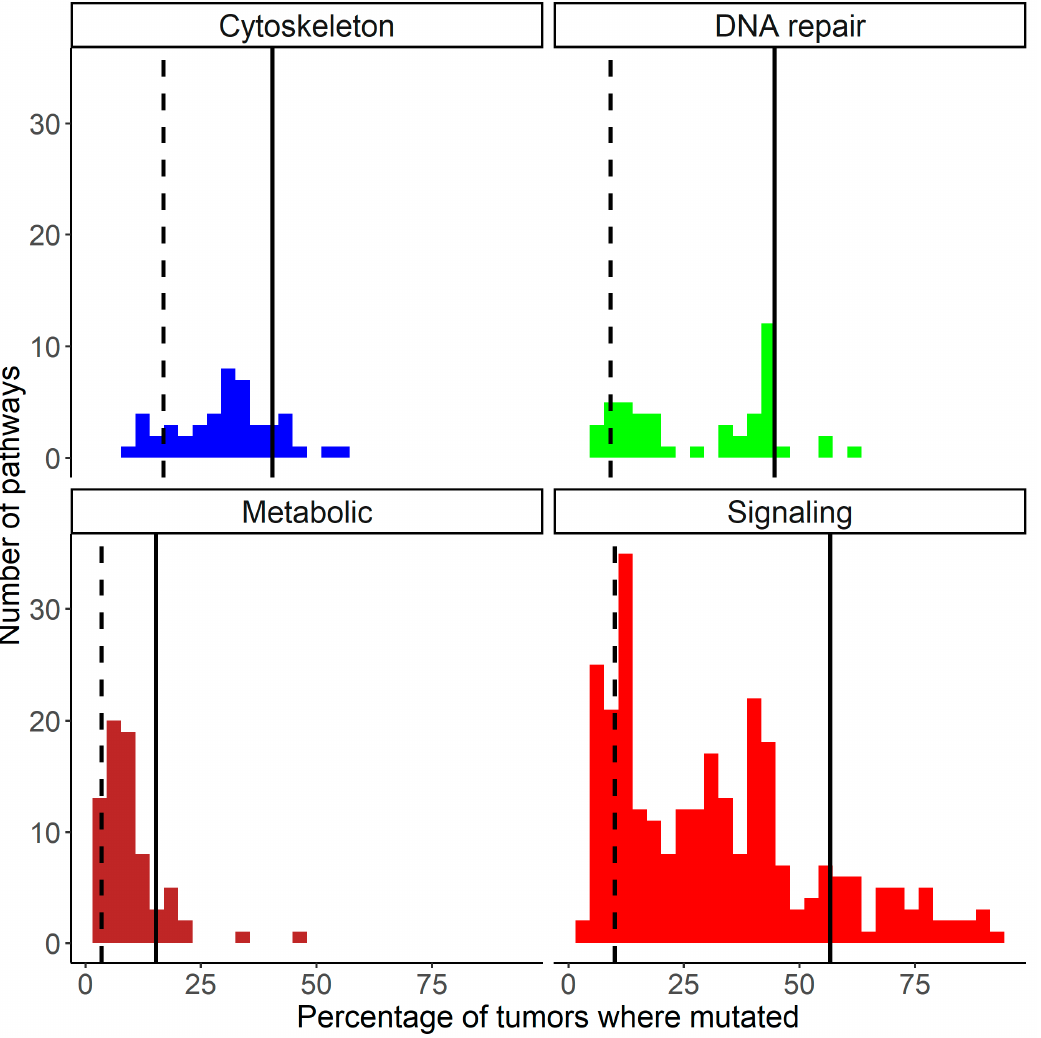
Figure 6. Distributions of molecular pathways according to percentage of tumor samples having mutations within them, for cytoskeleton, DNA repair, metabolic, signaling pathways. Vertical solid lines delineate 15% most frequently mutated pathways ( on the right ), vertical dashed lines delineate 15% least mutated pathways ( on the left ).